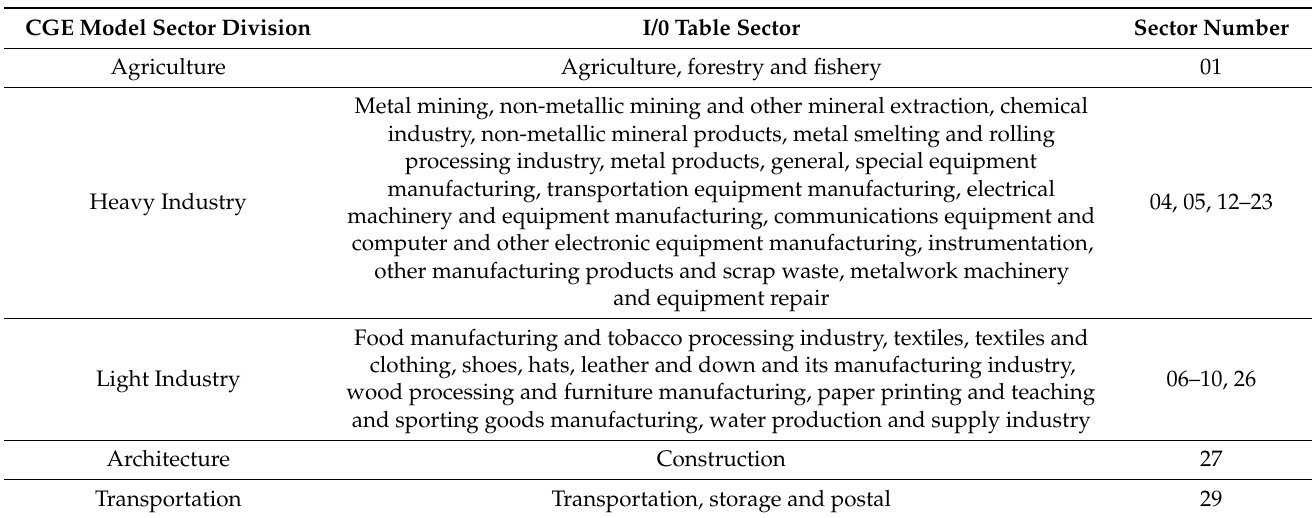
Table 1. CGE model and I/O table departmental correspondence